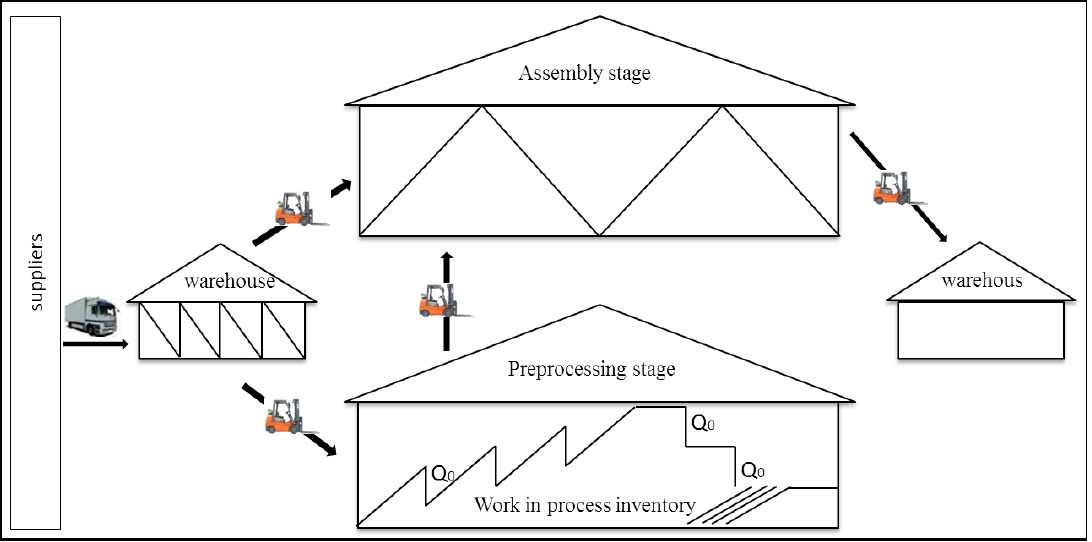
Fig. 1. Supply-production and distribution system in supply chain under